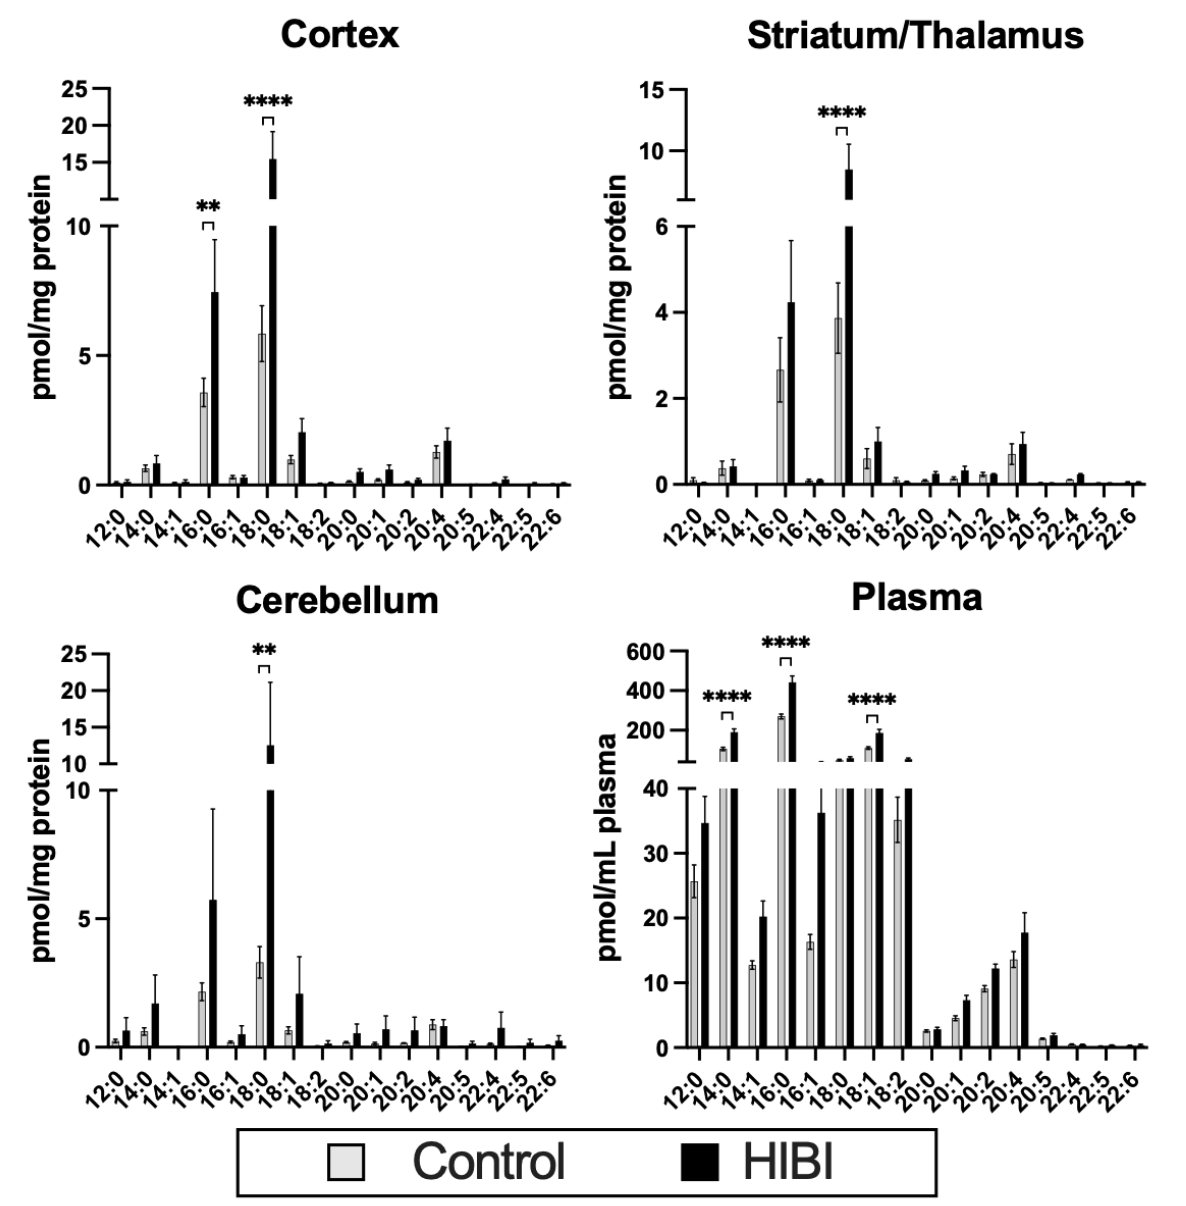
Figure 1. Individual acylcarnitine levels in brain regions and plasma at 30 min after HIBI compared with sham surgery controls. ** p < 0.01, **** p < 0.0001. Expression in the HIBI group normalized in the brain by 24 h after injury, including in those with severe injury, although some differences were noted in the cerebellum at 72 h after injury (Supplementary Material Figure S1). The plasma results were unchanged when restricted only to those with severe brain